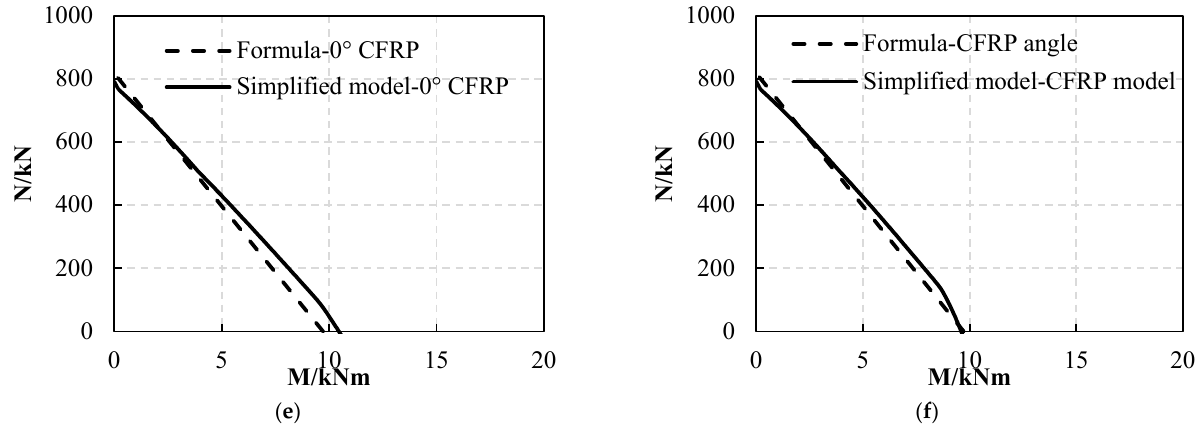
Figure 17. Comparison between formula results and simplified calculation model solutions: ( a ) benchmark; ( b ) variable: CFRP strength is 2000 MPa; ( c ) variable: steel grade is Q235; ( d ) variable: concrete grade is C40; ( e ) variable: the number of 0 ° CFRP layers is 0; ( f ) variable: the angle of 3 CFRP layers is 90 ° .